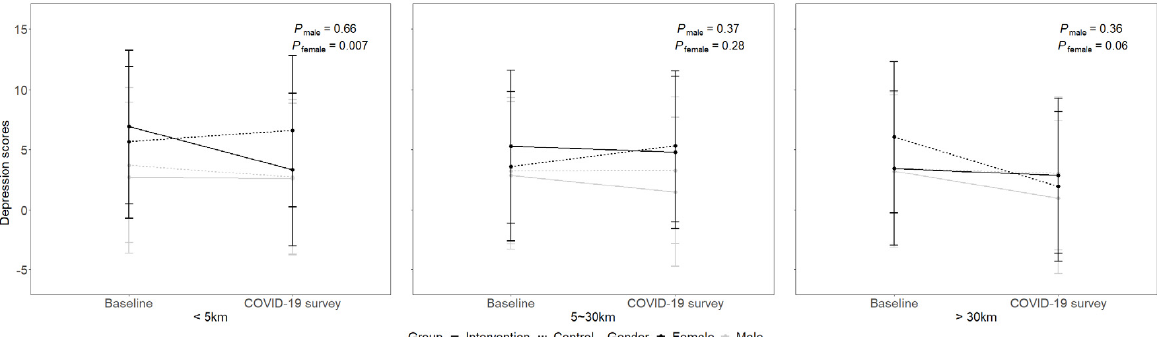
Figure 4. Longitudinal changes in gender-specific differences in depression scores between intervention and control groups by distance to the high-risk areas of COVID-19 in Guangzhou ( p -values for differences between intervention and control groups for male and female patients).